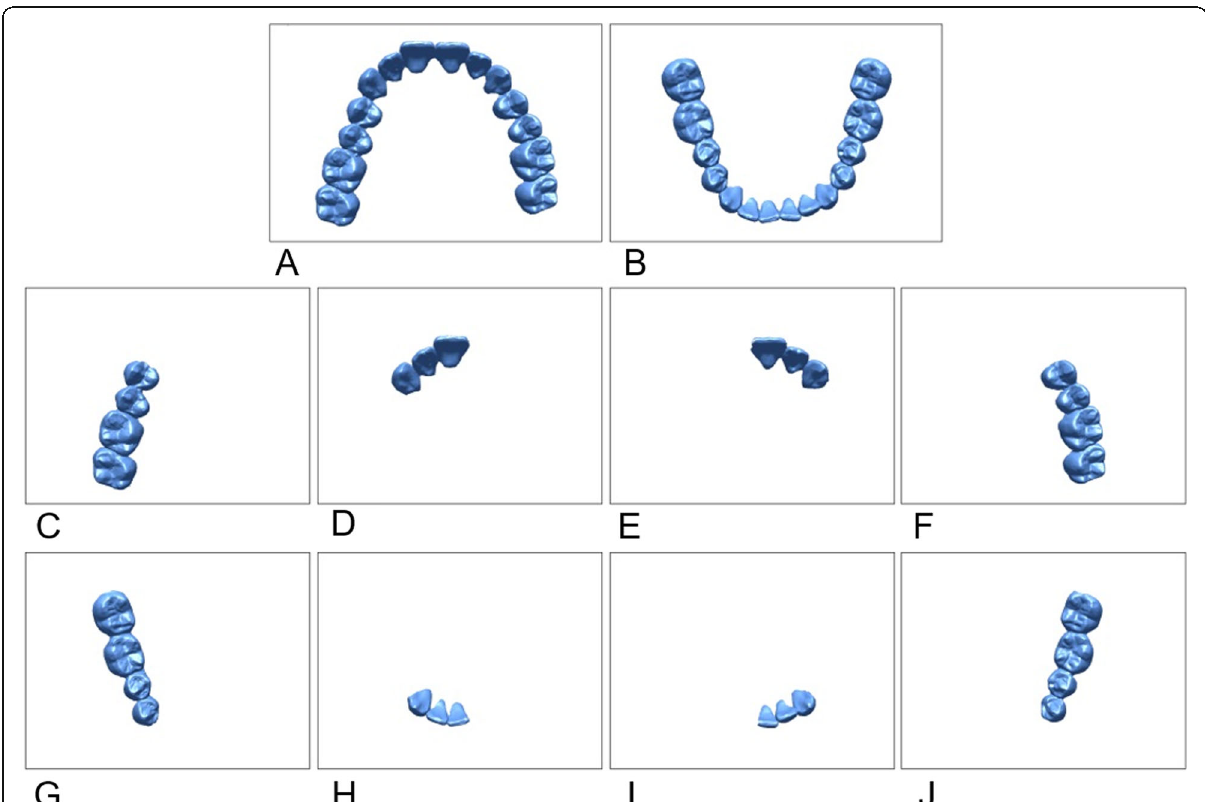
Fig. 1 Intraoral scans obtained from each patient. a , b Complete-arch scan; c – j Quadrant